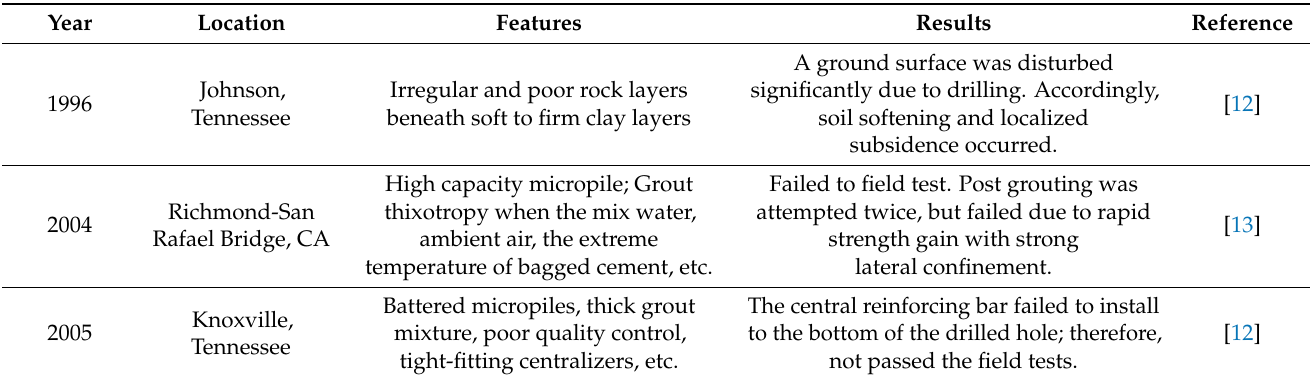
Table 1. Historical failures associated with